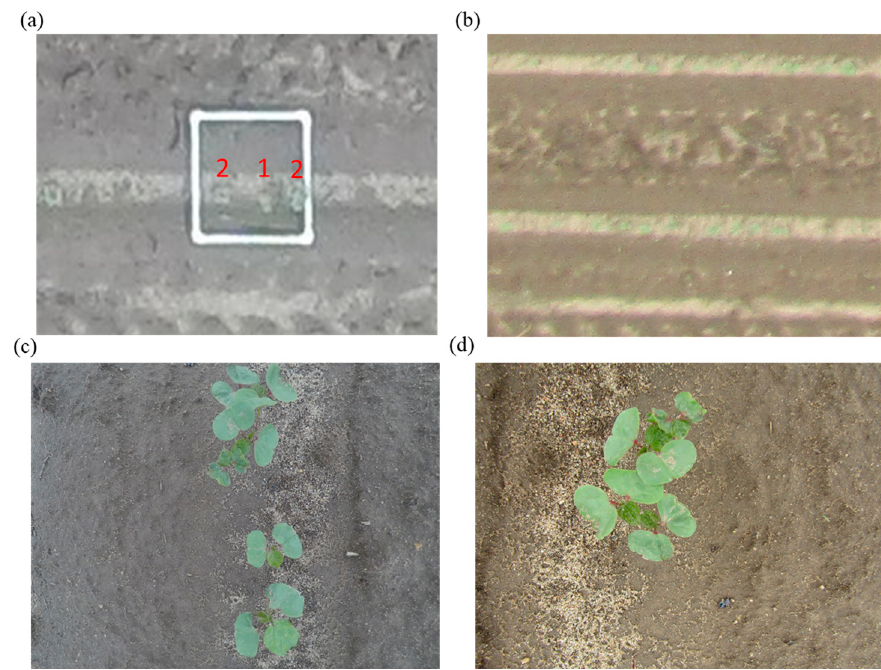
Figure 13. RGB images taken 15 days after planting in the test field. ( a ) and ( b ) are images flying at 15 m AGL. ( c ) and ( d ) are images taken at 0.30 m from the ground. The cotton seedlings in (a) could not be seen clearly due to image color distortion. The red text marks the number of seedlings counted in the field. The color of cotton seedlings in (b) is very close to the color of soil, creating a challenge for seedling segmentation.